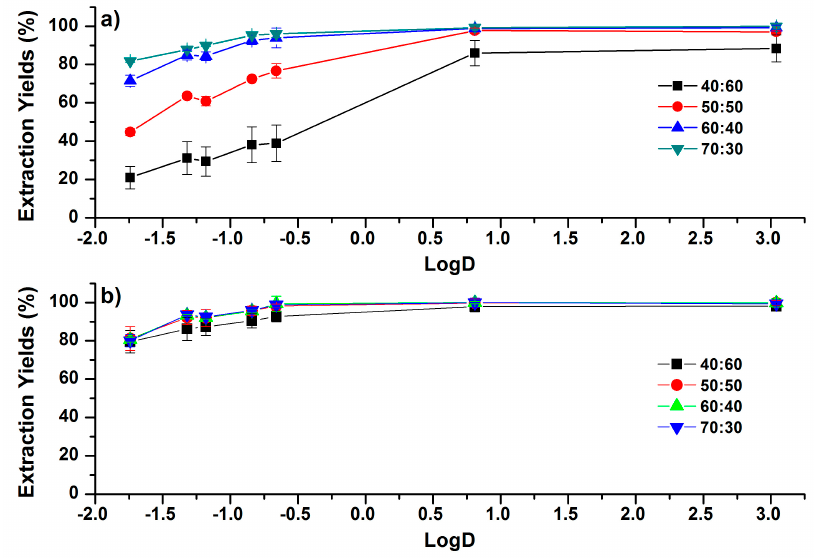
Figure 3. Correlations between EYs and the LogD (pH 7.4) values of phenolic compounds under different concentration of acetonitrile (ACN) in the ACN–H 2 O mixture (ACN:H 2 O, v / v ) for ( a ) NaCl- and ( b ) MgSO 4 -based salting-out assisted liquid–liquid extraction (SALLE). The addition amounts of salts were 75 g/L. Error bars present the standard deviation ( n = 3).